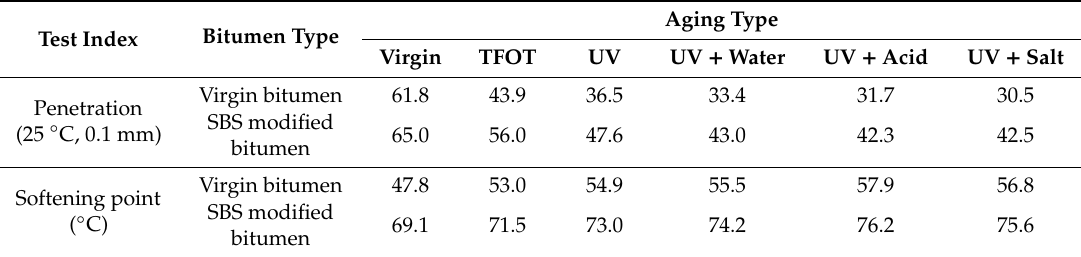
Table 3. Physical properties of virgin bitumen and SBS modified bitumen before and after UV aging in di ff erent aqueous